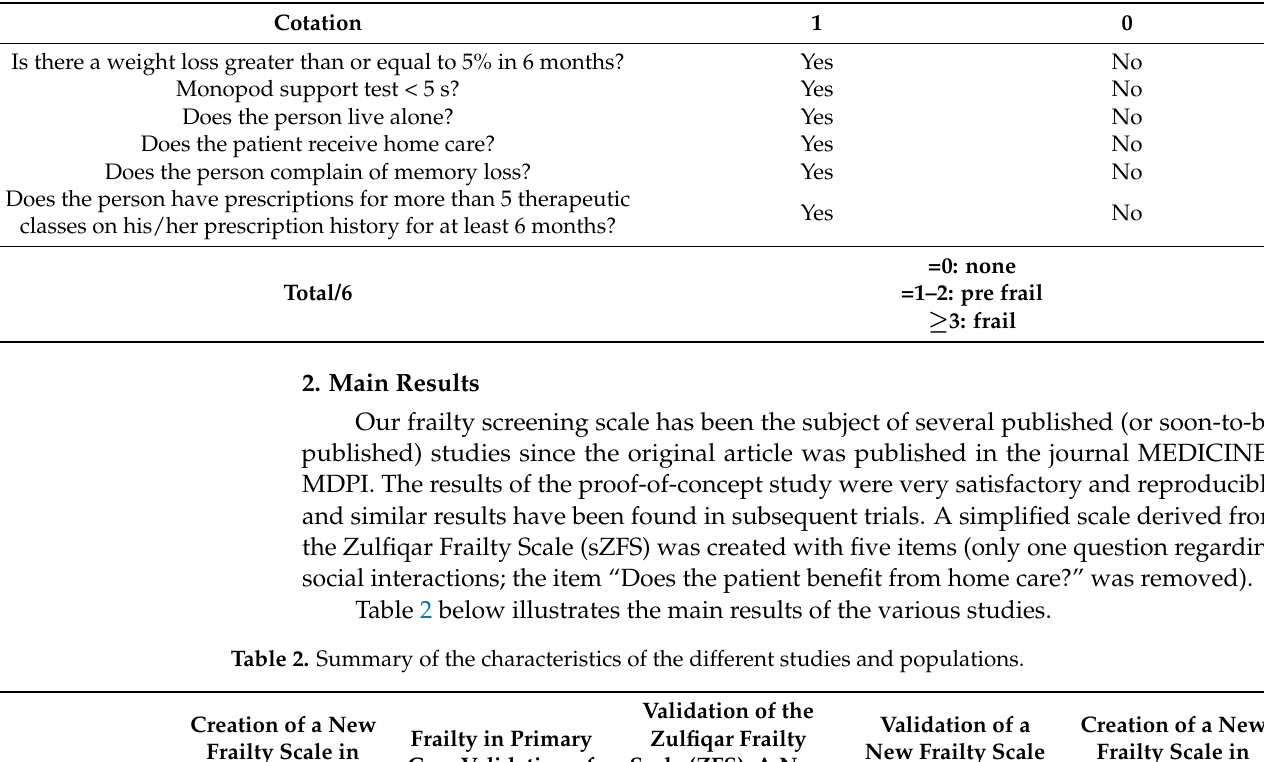
Table 1. Zulfiqar Frailty Scale: ZFS.